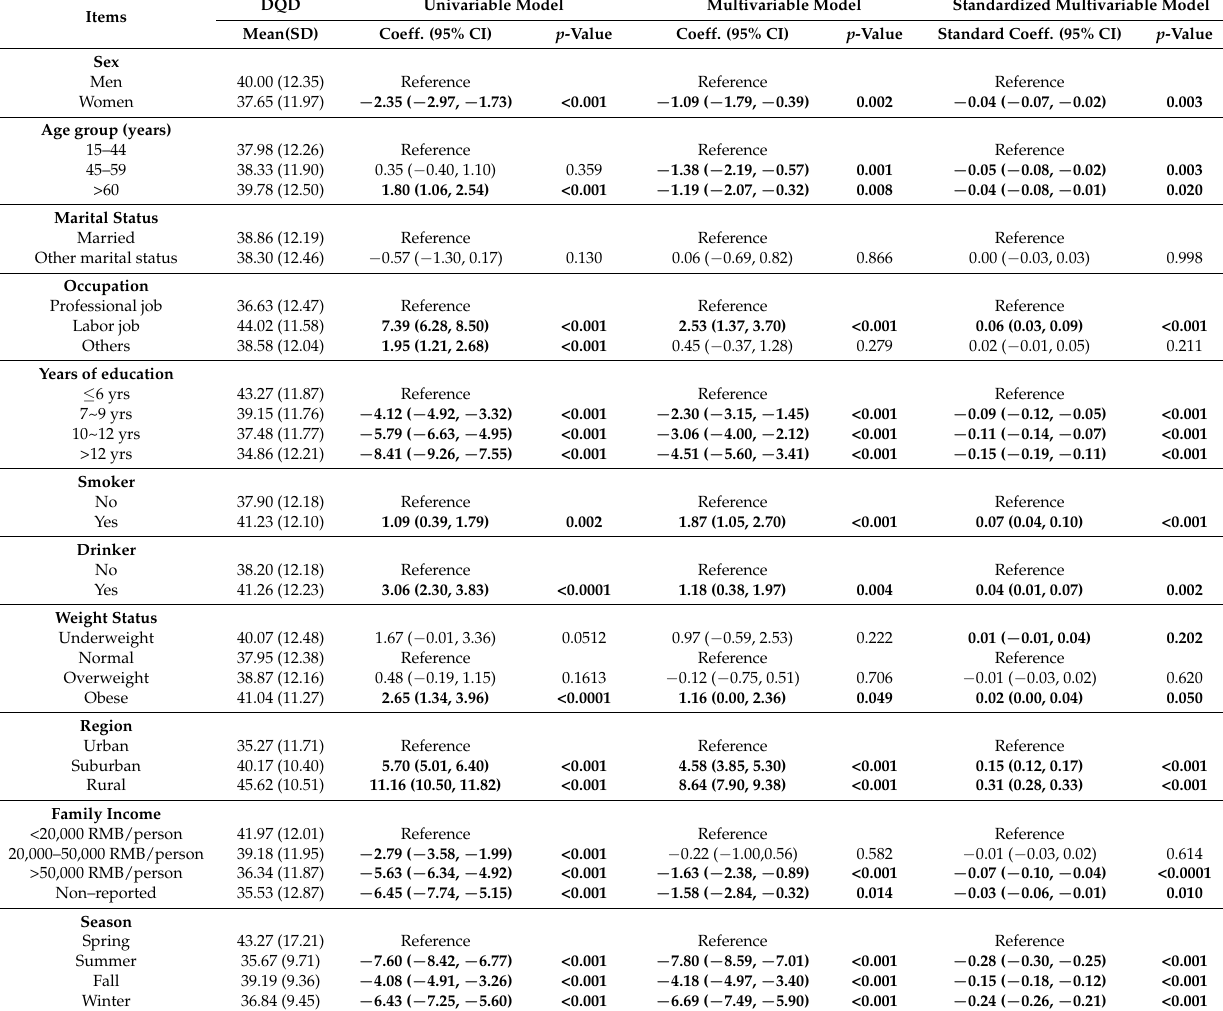
Table 4. Linear regression models for DQD, classified by